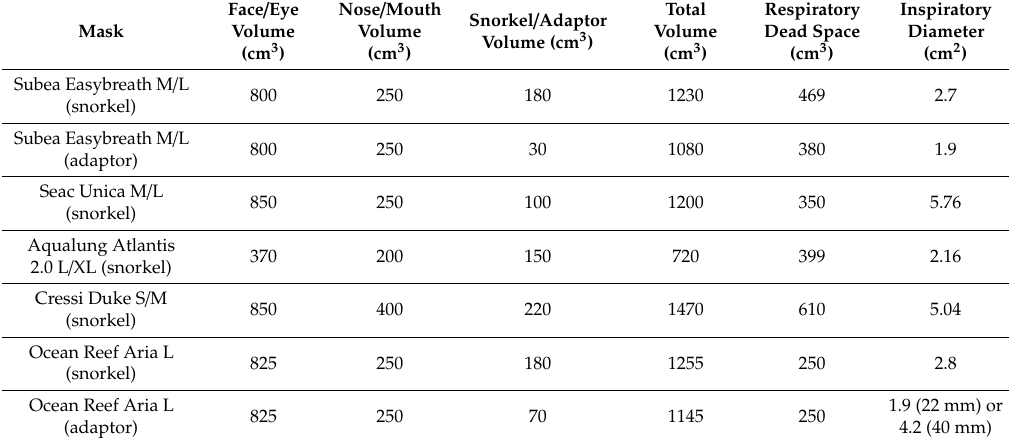
Table 3. Mask volumes and respiratory dead space.